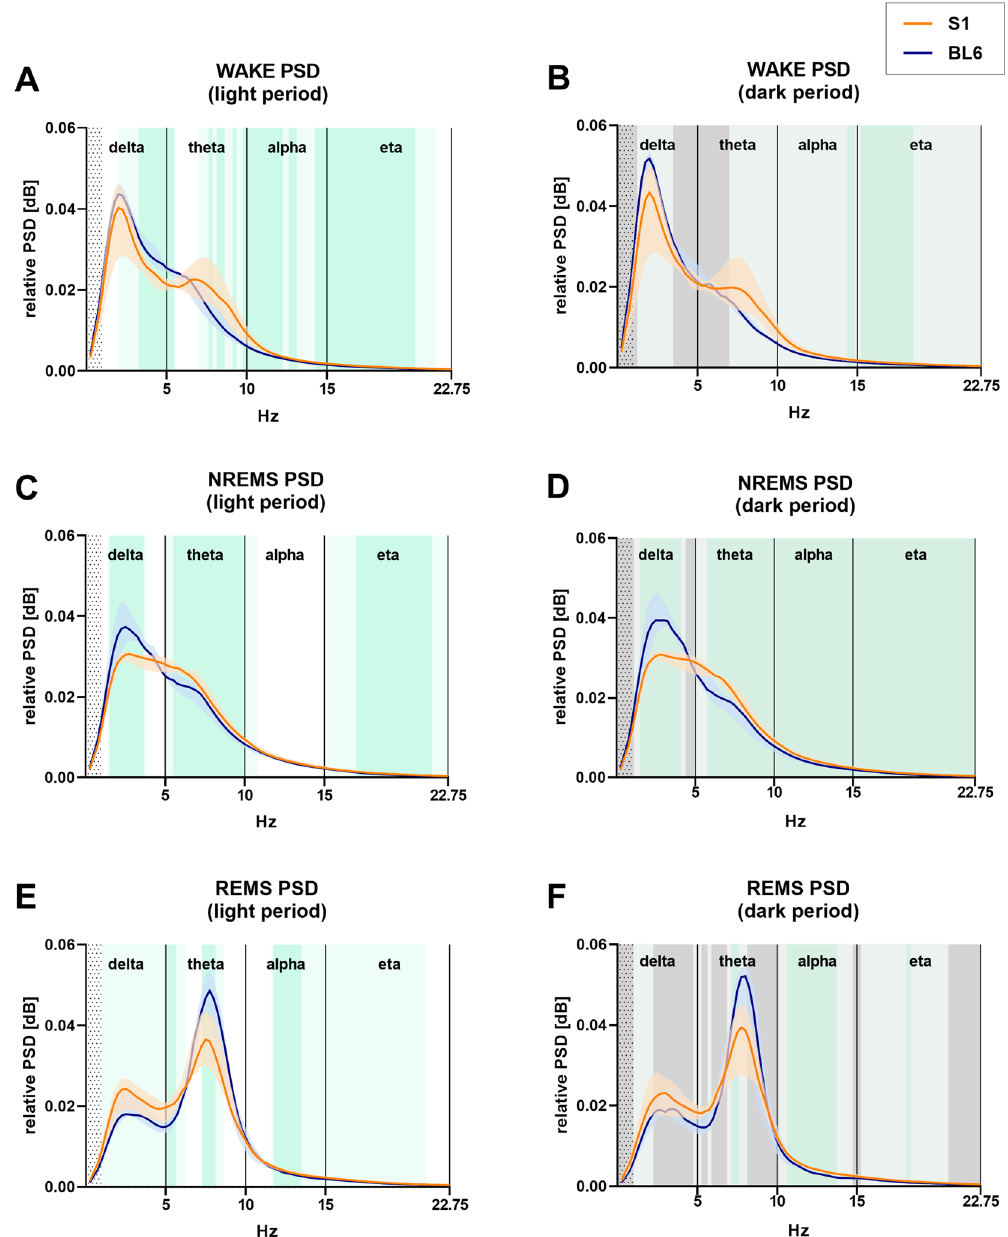
Figure 5. Power spectral density (PSD) in the 1–22.75 Hz frequency range (0.25 Hz bins) for each vigilance state in S1 (n = 6) and BL6 (n = 7) mice. During wakefulness in the light period ( A ), S1 mice showed lower power in the delta band (3.25–5.50 Hz), but significantly increased PSD in the high theta (7.75 Hz, 8.25–8.50 Hz, 9.25 Hz), alpha (9.75–12.25 Hz, 12.75–13.00 Hz, 14.25–15.00 Hz) and eta ranges (15.00–20.50 Hz). In the dark phase ( B ), WAKE eta power was higher in S1 than BL6 mice (15.25–18.25 Hz). S1 mice showed less power in the delta band [( C ) 1.75–3.50 Hz; ( D ) 1.75–4.00 Hz] during NREMS, while power in the theta range was increased [( C ) 5.50–10.00 Hz; ( D ) 5.75–10.00 Hz]. Also, NREMS alpha and eta power [( C ) 17.00–21.75 Hz; ( D ) 10.00–22.75 Hz] were higher in S1 than BL6 mice. The for REMS characteristic power peak around 8 Hz was decreased in S1 versus BL6 mice in light [( E ) 7.25–8.00 Hz] and dark period [( F ) 7.25–7.50 Hz]. Power in the alpha frequency band, however, was higher in S1 mice [( E ) 12.00–13.50 Hz; ( F ) 10.75–13.75 Hz]. All graphs show median PSD values in 0.25 Hz steps as lines plus shaded areas for interquartile ranges. Dotted areas indicate where a 1 Hz high pass filter was applied, dotted lines separate delta, theta, alpha and eta frequency bands. Green shaded areas indicate that the CI did not include 0.5, i.e. statistical significance, light green shades indicate AUC values > 0.7; i.e. relevant